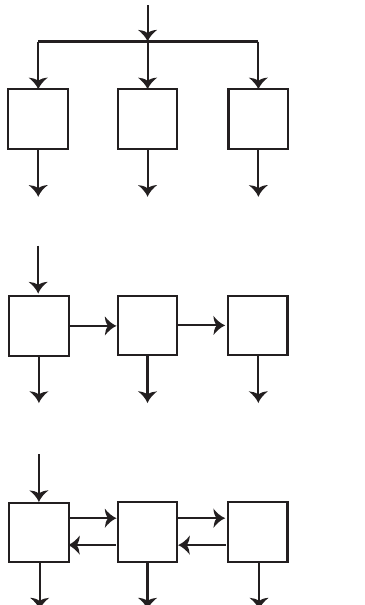
Figure 1. Possible structures for a three-pool model. Each box rep- resent a pool with a specific decomposition rate, and arrows rep- resent inputs to or outputs from the pools. In the first case, carbon enters the system and it is split among the three pools in different proportions without any transfer between pools. In the second case, carbon enters the system through one reservoirs and it is transferred serially between compartments. In the third case, carbon is returned back to donor